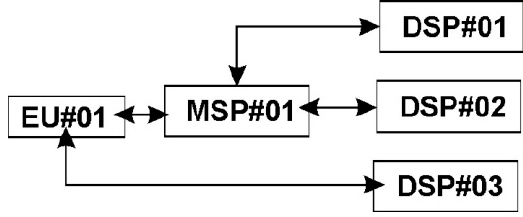
Figure 1. Hybrid Data Mashup.